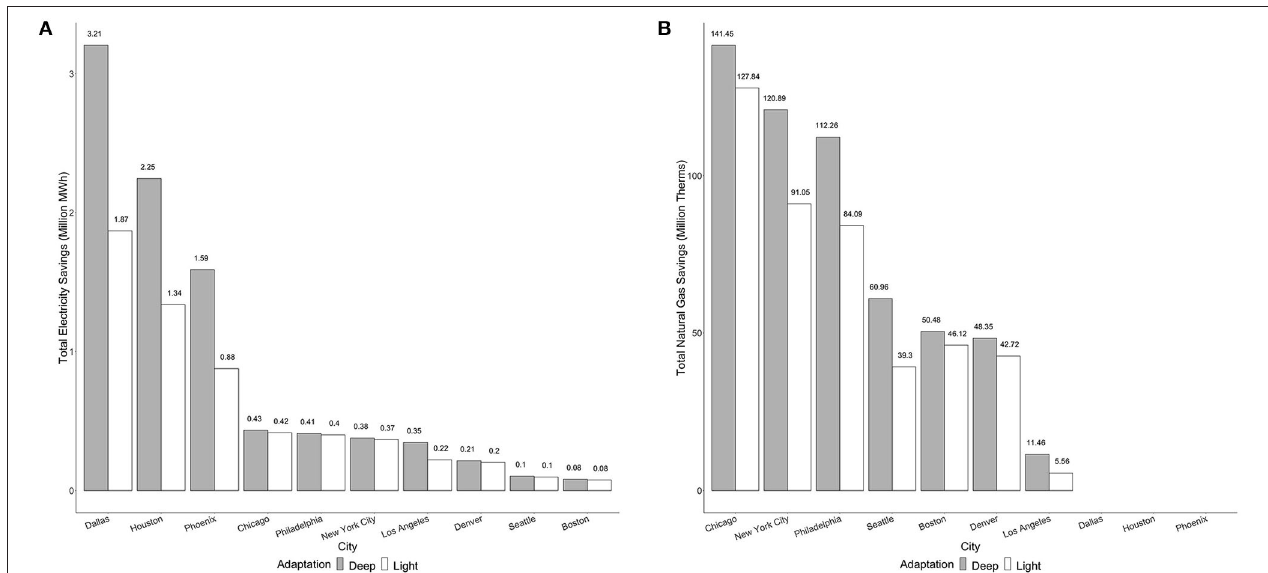
FIGURE 2 | (A) Modeled electricity (million MWh) and (B) natural gas (million therms) savings for each of the 10 US cities simulated with light (relatively easy) vs. deep (more difficult) heat adaptation retrofits of single-family detached homes built from 1990 to 2010. In Phoenix, Dallas, and Houston, our archetypical building model had electric resistant heating instead of a natural gas furnace or boiler.